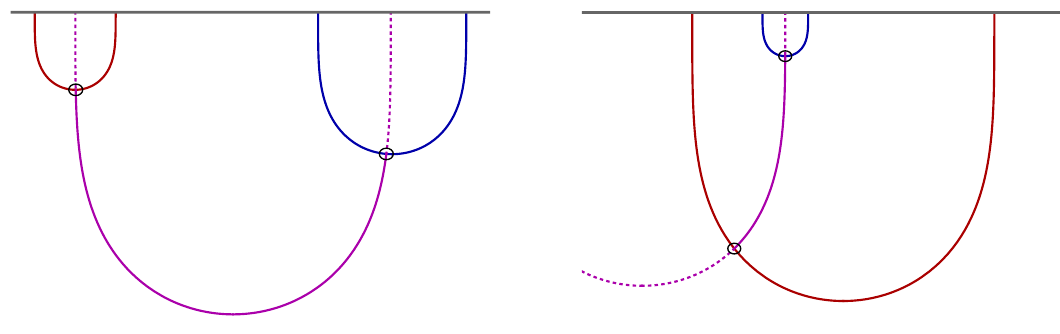
Figure 19 . The configurations appearing in the numerical minimization procedure for the EWCS. The red and blue curves are fixed (minimal) surfaces, parts of the boundary of the entanglement wedge. The magenta curve presents the cross section that needs to be